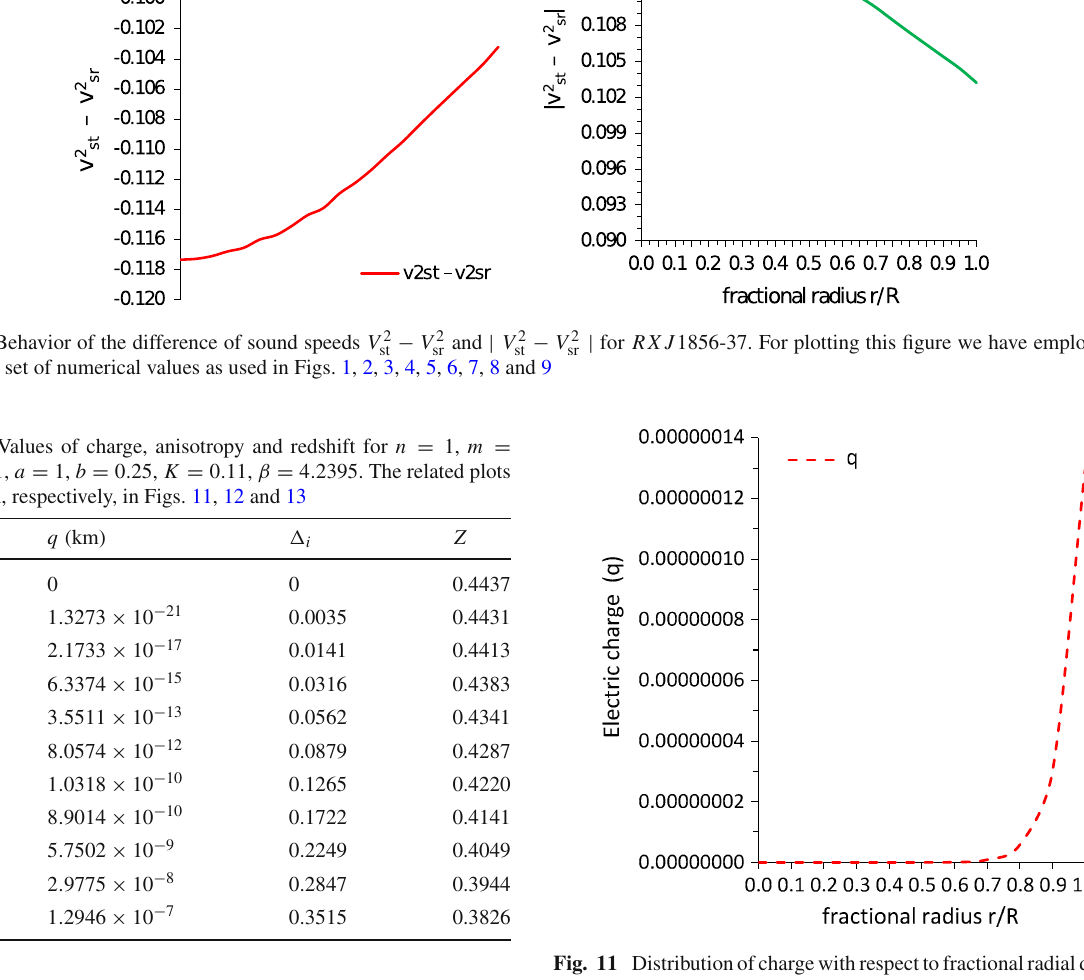
Fig. 11 Distributionofchargewithrespecttofractionalradialdistance ( r / R ) for RX J 1856-37. For plotting this figure we have employed the same data set of numerical values as used in Figs. 1, 2, 3, 4, 5, 6, 7, 8, 9 and